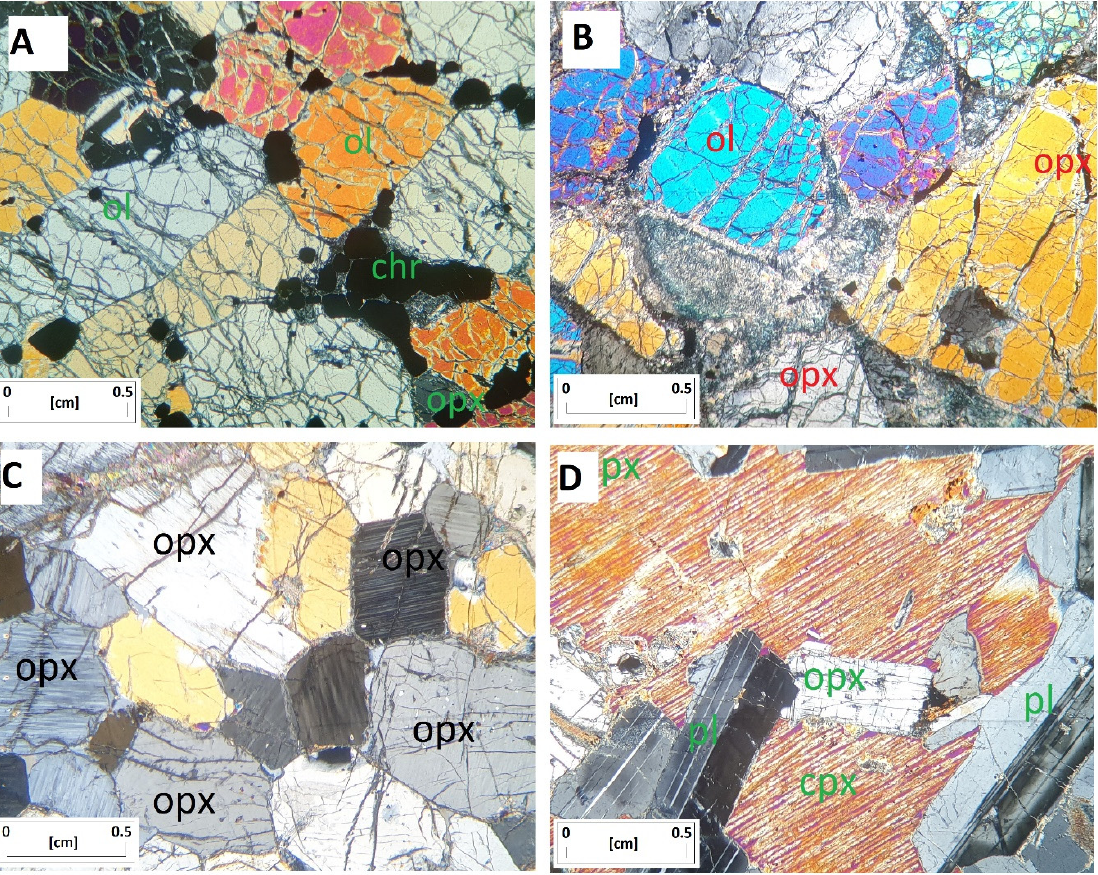
Figure 3. Examples of typical rocks from Moncheplutonu. ( A ) Dunite. ( B ) Harzburgite. ( C ) Orthopyroxenite. ( D ) Gab- bronorite. Abbreviations: opx -orthopyroxene, cpx – clinopyroxene, ol – olivine, chr – chromite, pl – plagioclase.